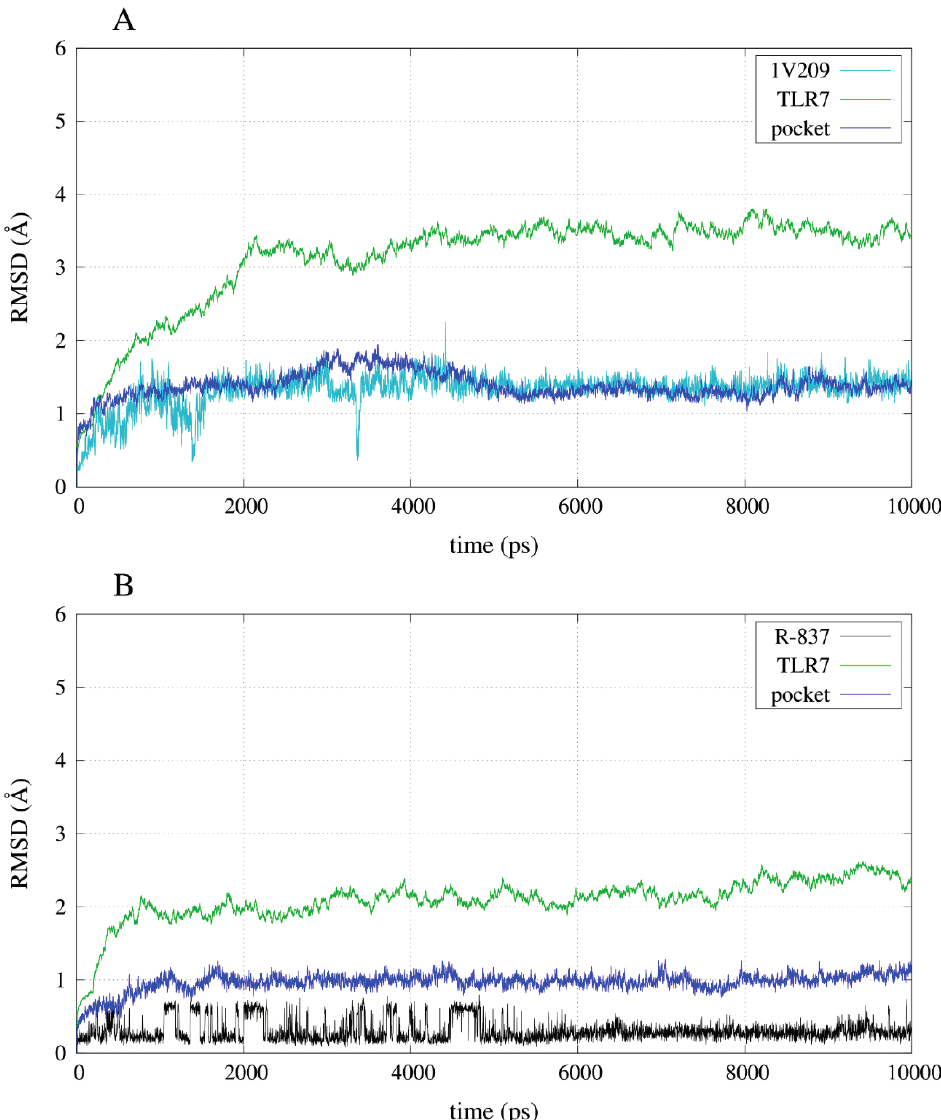
Figure 7. RMSD trends for backbone, binding pocket and two selected agonists. ( A ) RMSD for 1V209 in complex with TLR7; ( B ) RMSD for R-837 in complex with